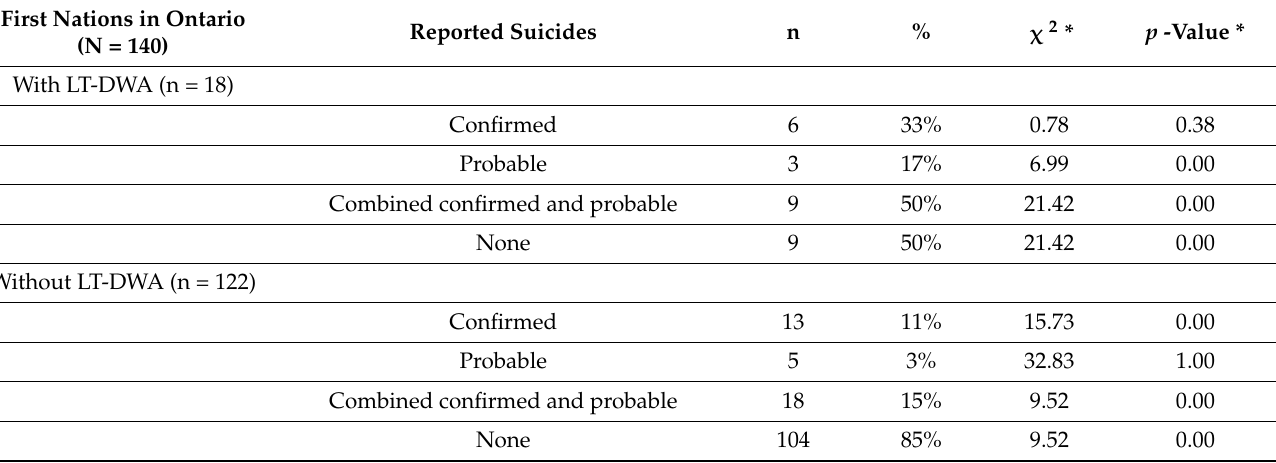
Table 2. Suicide Distributions for First Nations with and without Long Term Drinking Water Ad- visories (LT-DWAs) in Ontario Compared to Reported Provincial Proportion of First Nations with Suicides Between